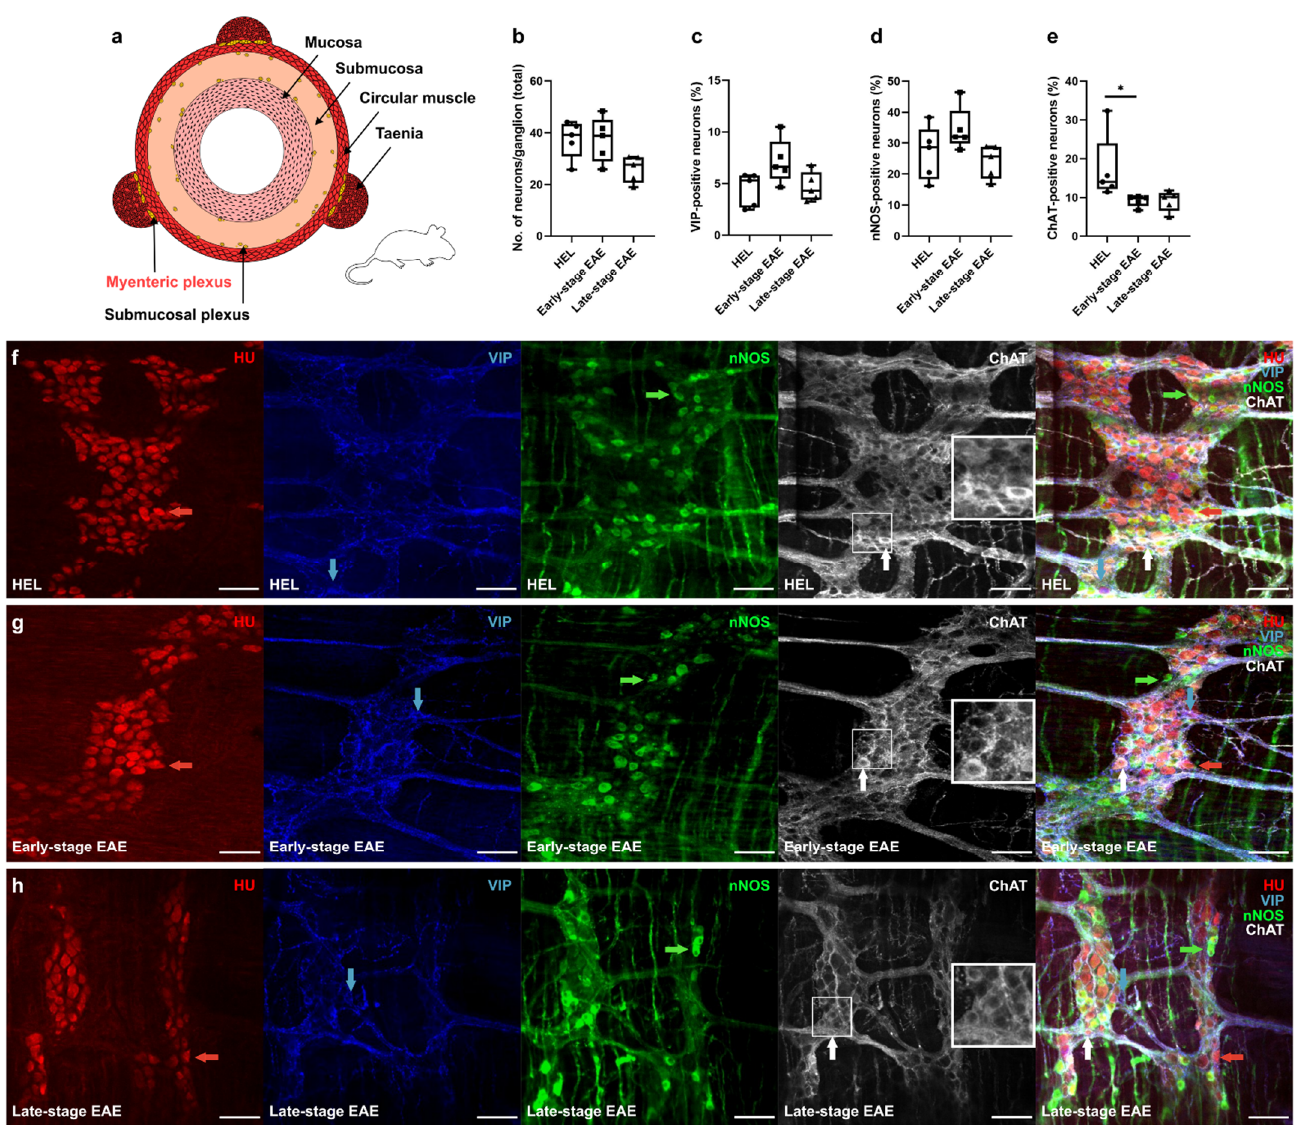
Figure 2. Immunohistological staining of the murine myenteric plexus (MP). ( a ) Whole mounts were obtained from the colons of female C57BL/6J mice with early-stage experimental autoimmune encephalomyelitis (EAE) ( n = 5), late-stage EAE ( n = 5), or after immunization with the control antigen hen egg lysozyme (HEL) ( n = 5). ( b ) Numbers of neurons per ganglion analyzed in each group. ( c – e ) Percentage of ( c ) vasoactive intestinal peptide (VIP) + , ( d ) neuronal nitric oxide synthase (nNOS) + , and ( e ) choline acetyltransferase (ChAT) + neurons in relation to the total number of HuC/D (HU) + neurons in each group. Individual data points display mean values per mouse. The box and whisker plots show median values, together with the interquartile range. For normally distributed data, statistical significance was determined by one-way analysis of variance; otherwise, a Kruskal–Wallis test was applied with * p < 0.05. ( f – h ) Representative single-optical sections from z-stacks (z-steps: 1.0 µm) of quadruple staining for HU ( red arrow , first column), VIP ( blue arrow , second column), nNOS ( green arrow , third column), ChAT ( white arrow , fourth column) and the combination of all four (fifth column) in ( f ) HEL-immunized, ( g ) early-stage EAE, and ( h ) late-stage EAE mice. Scale bars denote 50 µm. Higher magnification insets for ChAT highlight statistically significant alterations; each side accounts for 50 µm.